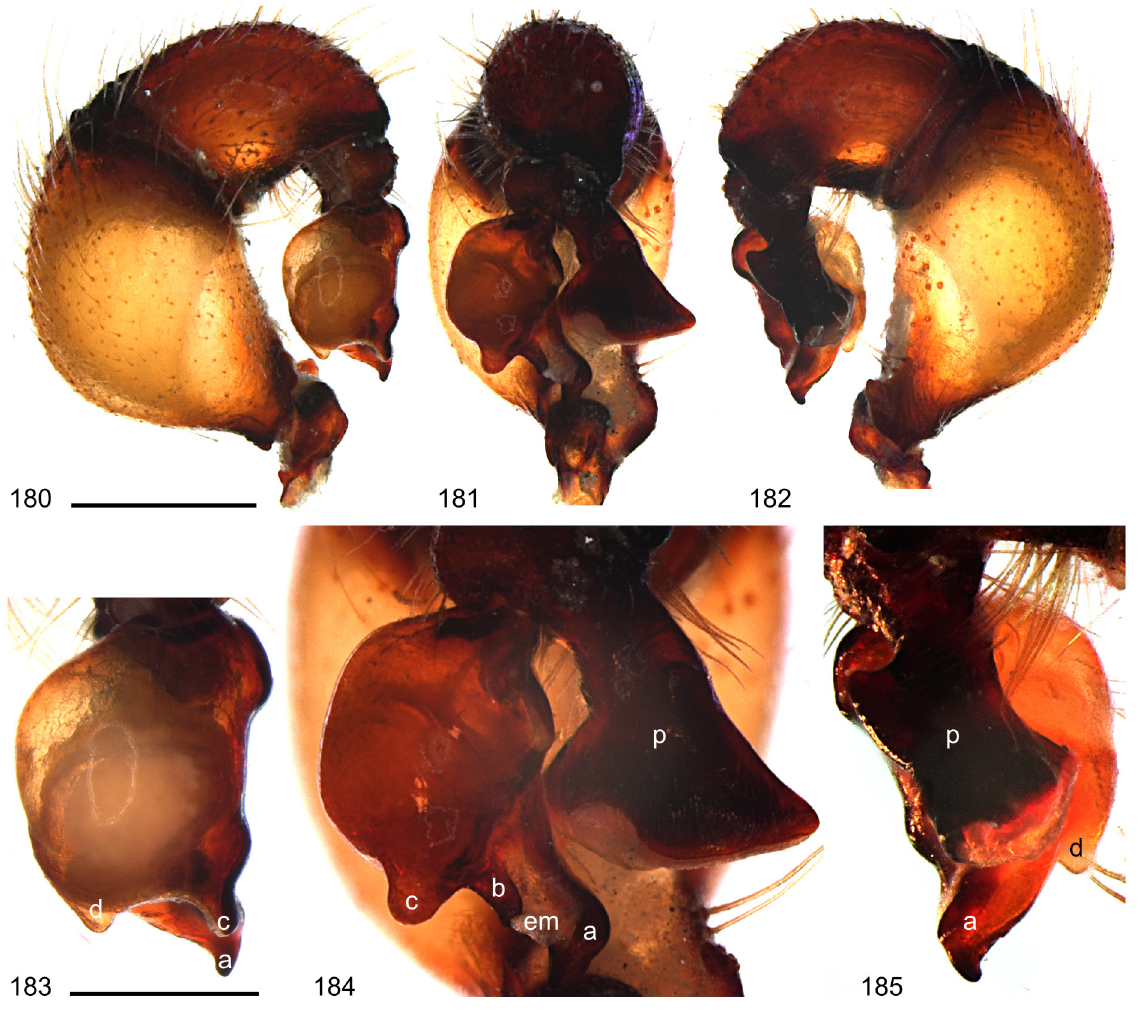
Figs 180–185. Artema sp. c from Pakistan, Baluchistan Province, Quetta (ZMMU). 180–182 . Male left pedipalp: prolateral, dorsal, and retrolateral views. 183–185 . Male left bulb and procursus: prolateral, dorsal, and retrolateral views. Scale lines: 180–182 = 1 mm; 183–185 =